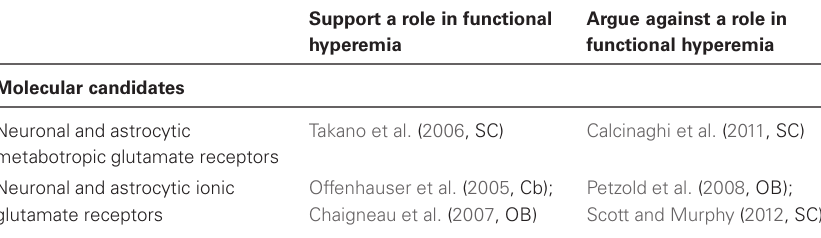
Table 1 | Examples of receptor candidates for the feed-forward triggering of CBF increase in vivo